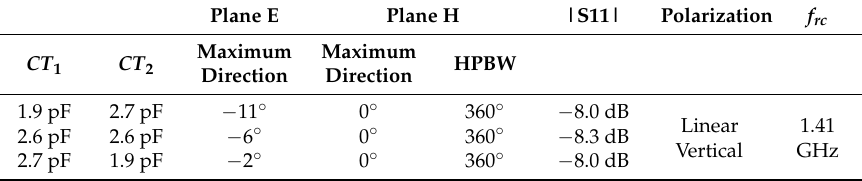
Table 11. Conclusions drawn from the tests carried out in the anechoic